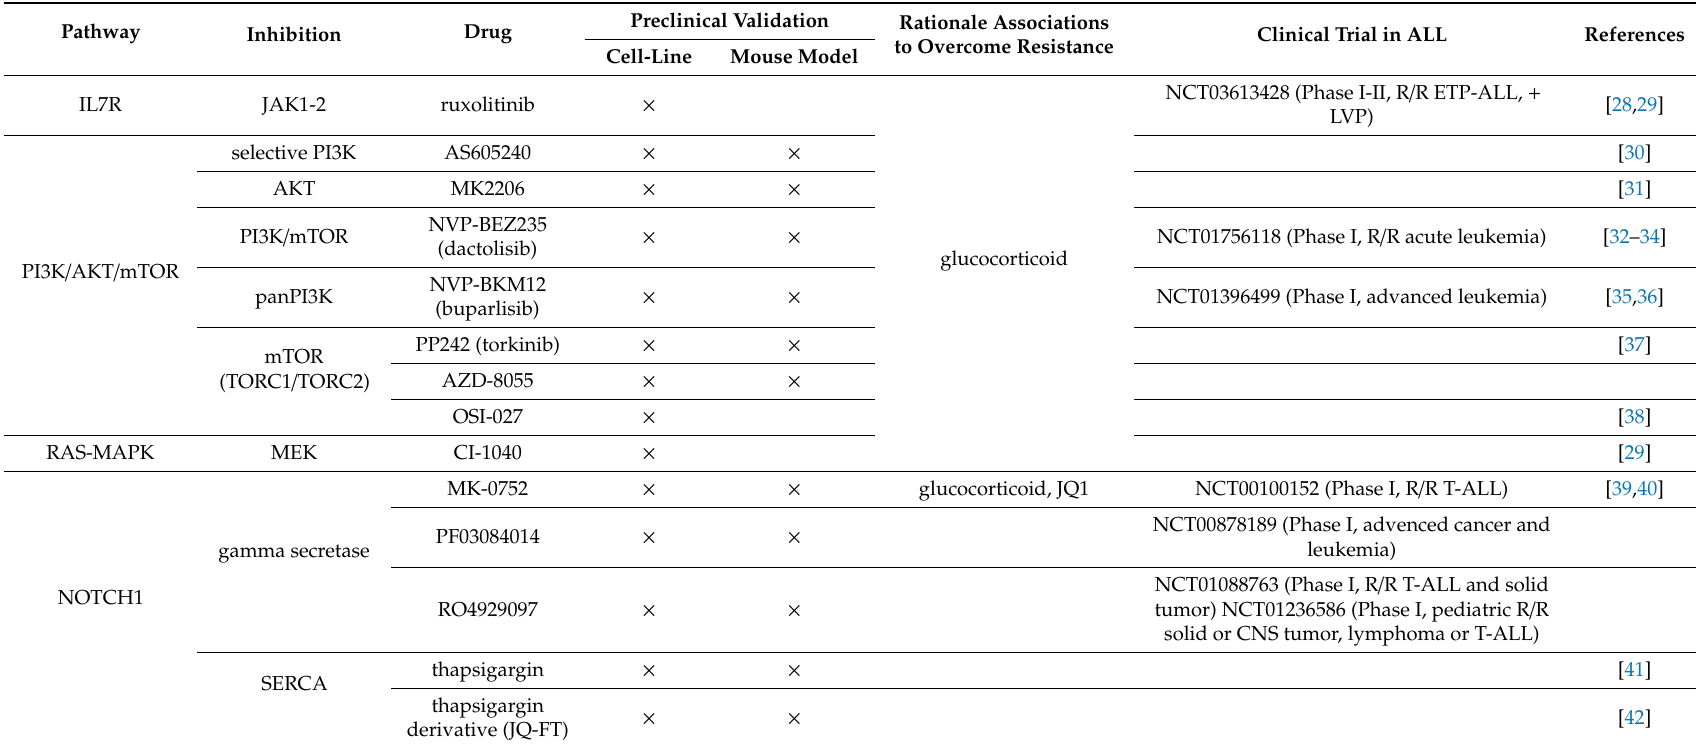
Table 1. Inhibitors targeting signaling pathways in preclinical and early clinical